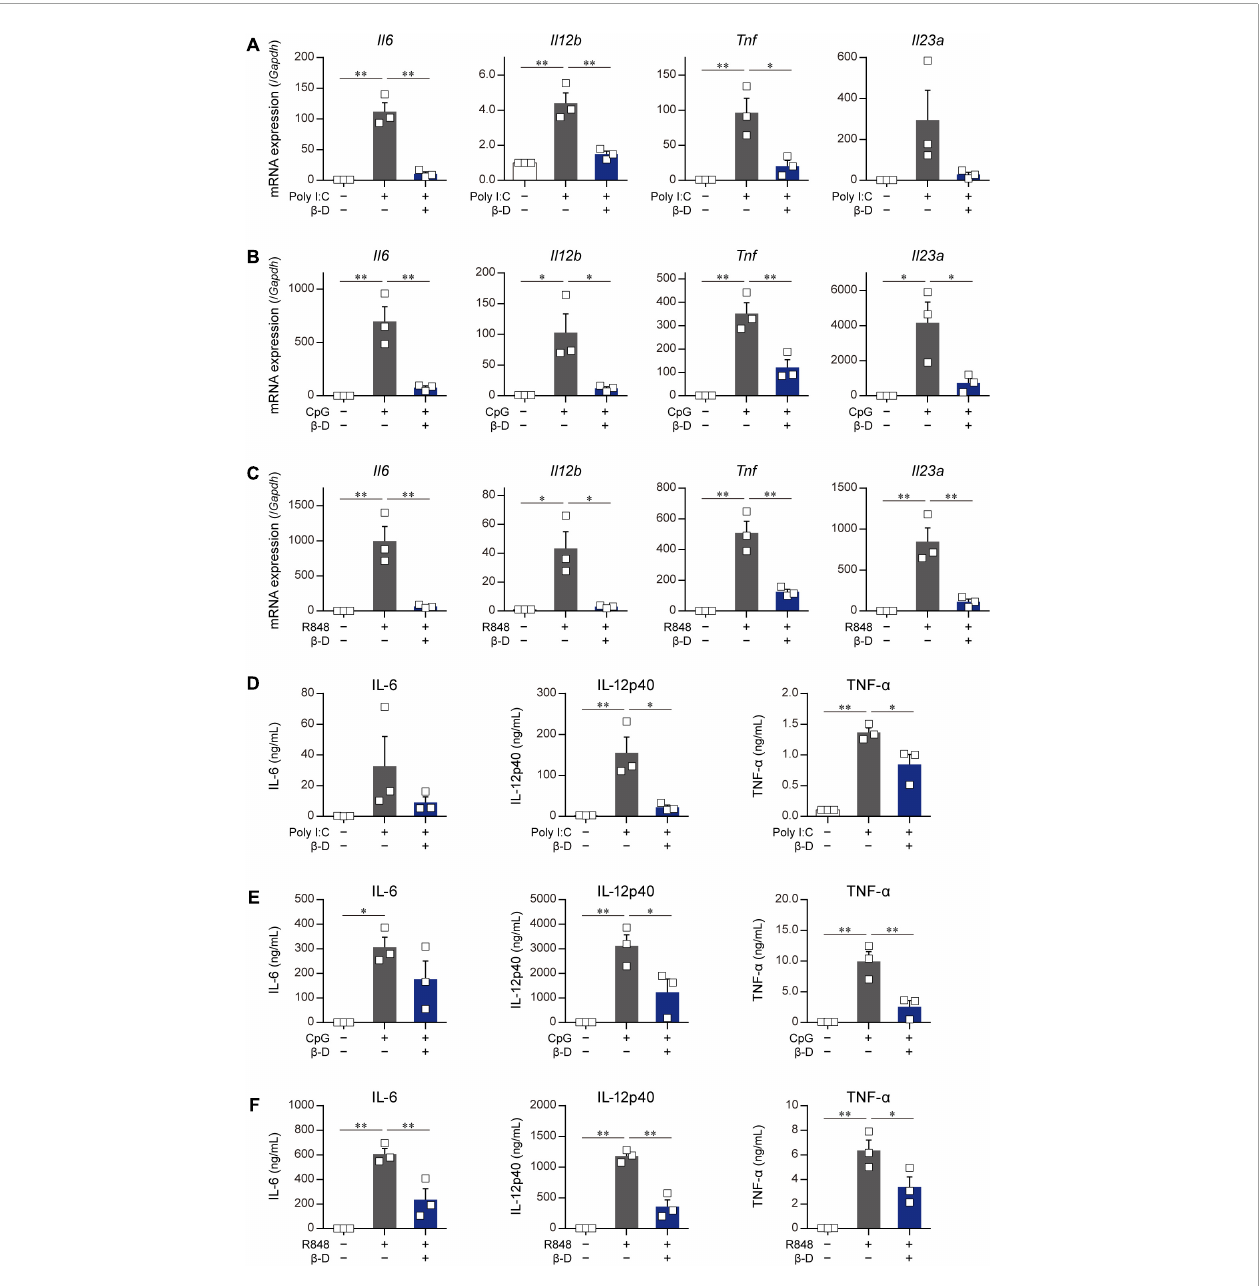
FIGURE3 Suppressive effects of β -damascone on the stimulation of DCs by various TLR ligands. The effects of β -damascone (50 µ M) on mRNA expression levels in panels (A–C) and the protein release of cytokines (D–F) from BMDCs stimulated with poly-I:C (A,D) , CpG (B,E) , or R848 (C,F) . BMDCs pretreated with 50 µ M β -damascone for 24 h were stimulated with 25 µ g/ml poly-I:C, 1 µ g/ml CpG, or 1 µ g/ml R848, and the cells were harvested at 3 h after stimulation to determine mRNA levels and the culture media were collected at 24 h after stimulation to assess cytokine concentrations. Data represent the mean ± SEM of three independent experiments performed in triplicate samples. The Tukey-Kramer test was used. ∗ p < 0.05, ∗∗ p <